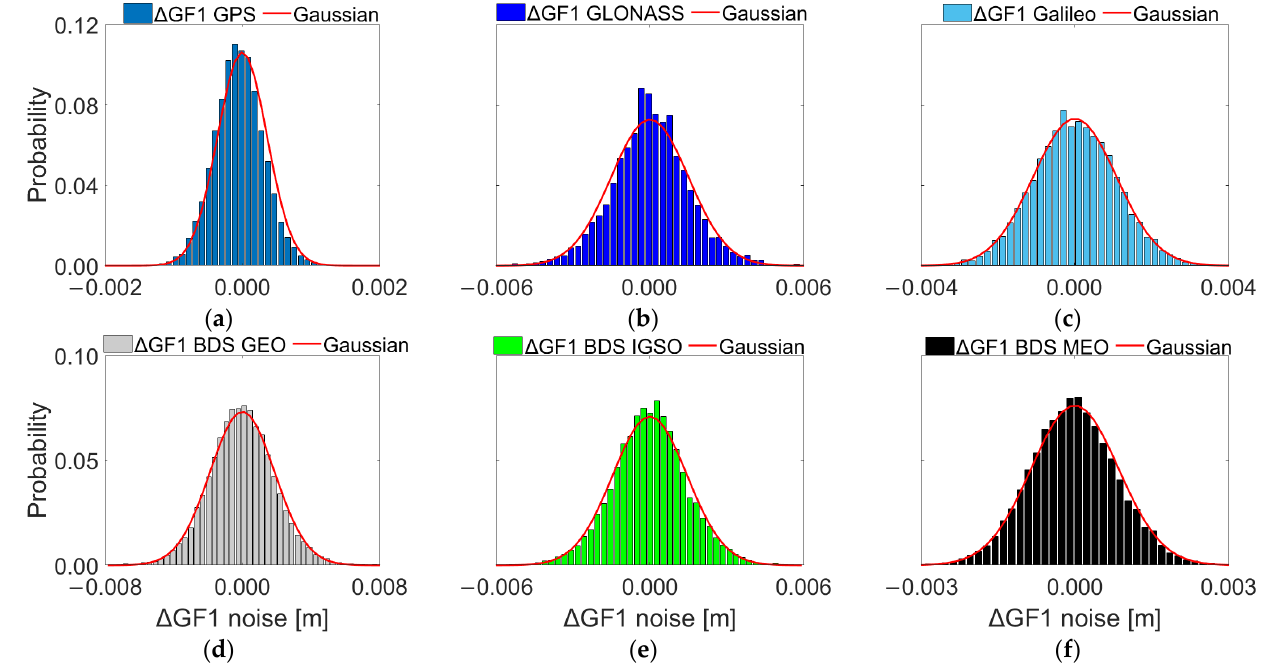
(cid:0) (cid:0) ∆ (cid:1)(cid:1) GF 1, k , r 0,var of ( a ) GPS, ( b ) GLONASS, ( c ) Galileo, ( d ) BDS GEO, Figure 1. ∆𝐺𝐹 (cid:2869) , (cid:3038) , (cid:3045) PDF and N (cid:4672) 0,var (cid:3435)∆𝐺𝐹 (cid:2869) , (cid:3038) , (cid:3045) (cid:3439)(cid:4673) of ( a ) GPS, ( b ) GLONASS, ( c ) Galileo, ( d ) BDS GEO,